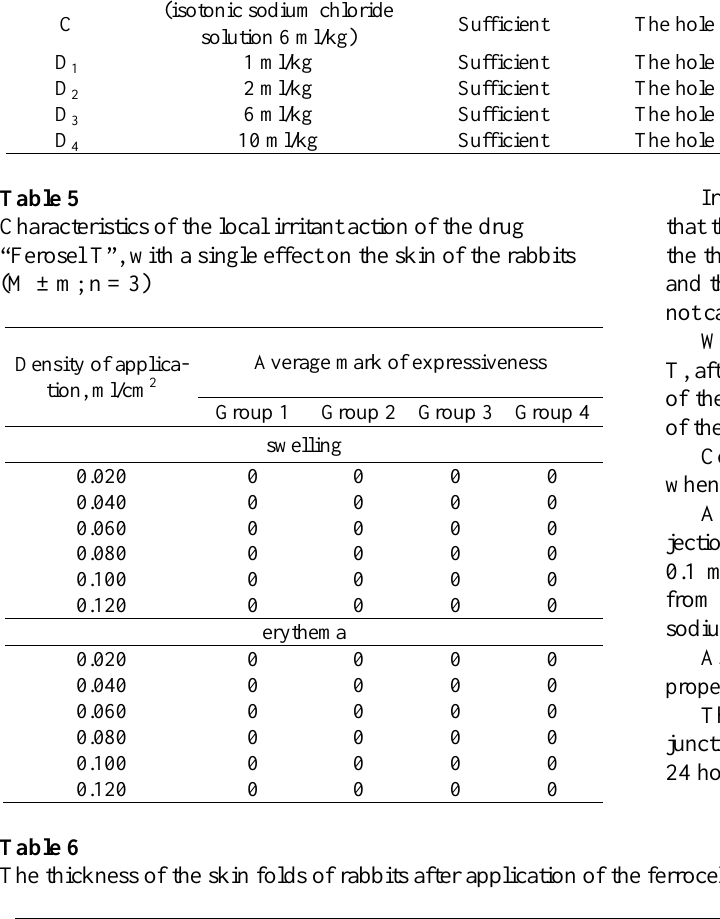
The thickness of the skin folds, mm